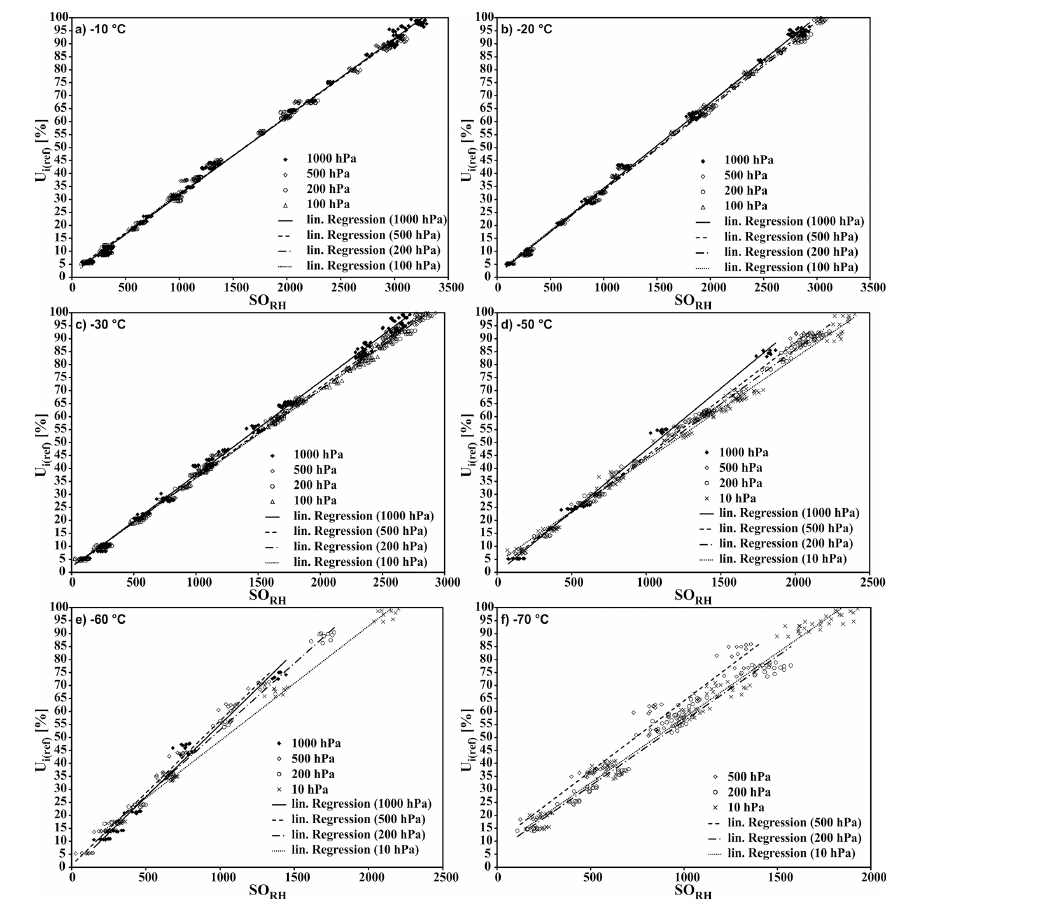
Figure 8. Pressure dependency of all SHT75 sensors at temperatures from − 70 to − 10 ◦ C. Pt100 onto the SHT75 (see Sect. 3.1.3). A final